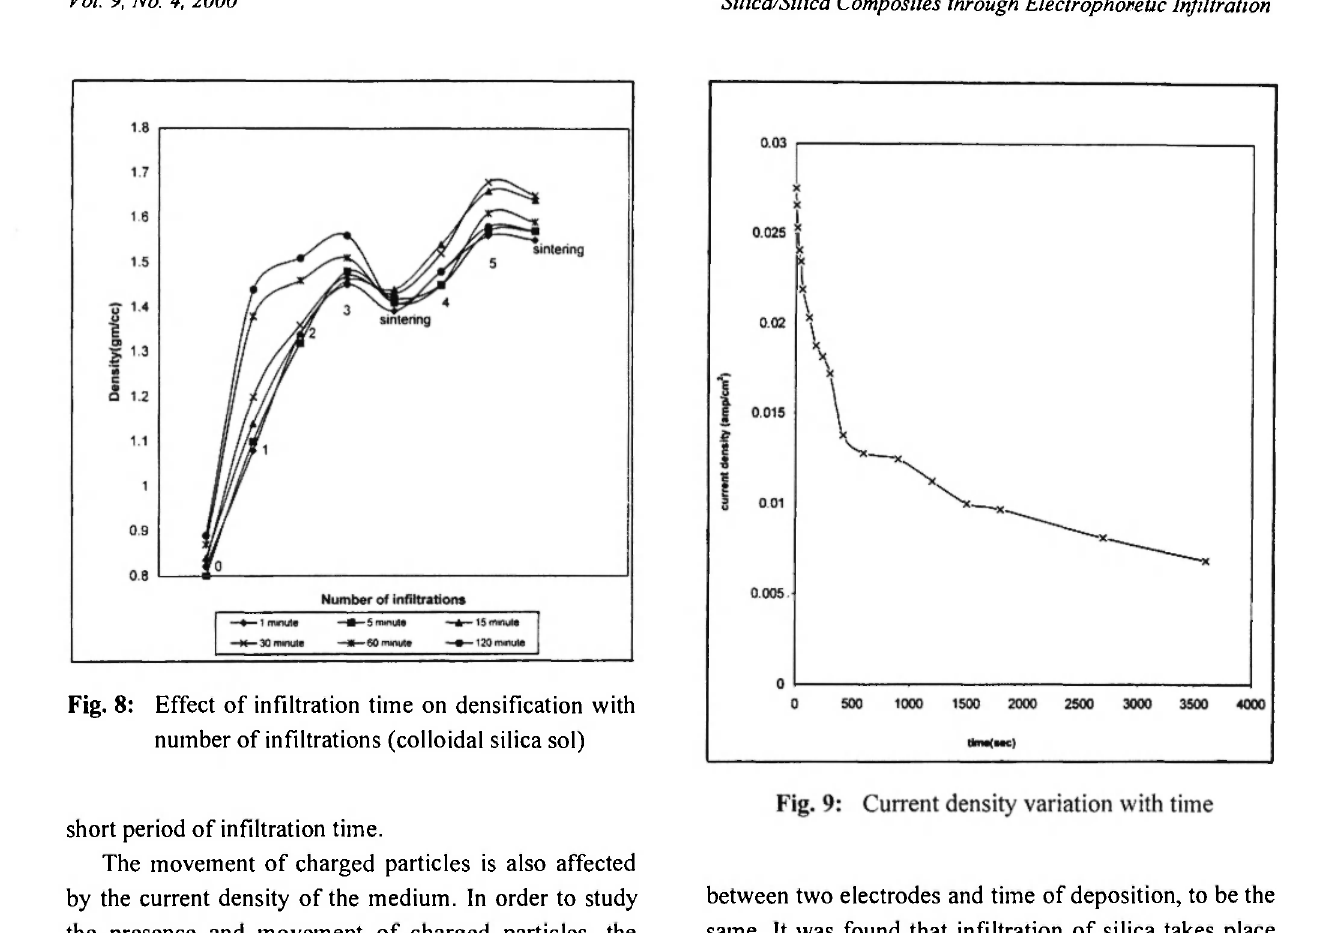
short period of infiltration